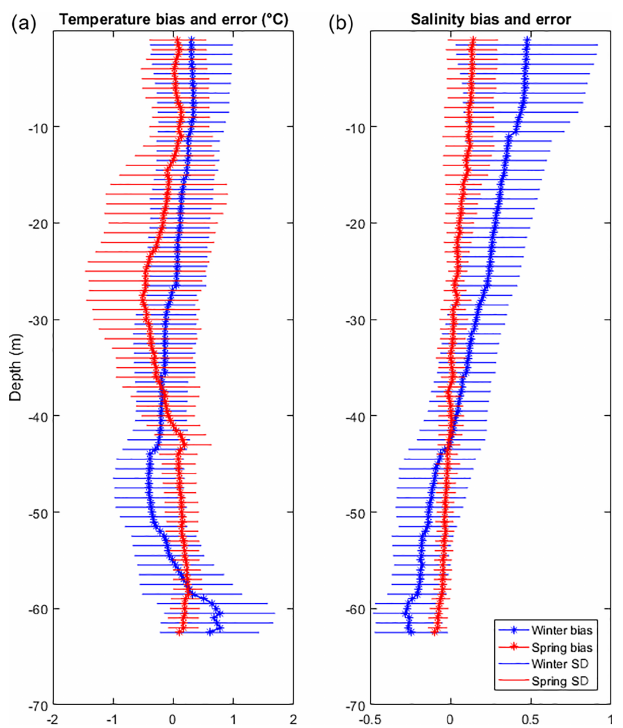
Figure 8. Vertical profiles of the model-to-observation bias (thick vertical lines) and the root-mean-square error (horizontal lines) av- eraged over 1m vertical bins over all CTD stations (1–19) during the leg 1 (winter, blue) and leg 2 (spring, red)